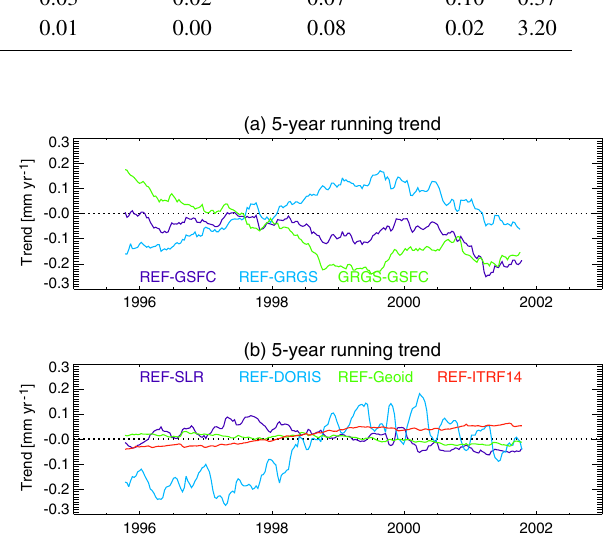
Figure 4. The 5-year running trends for the global mean radial orbit differences over the oceans for REF minus GSFC (dark blue), REF minus GRGS (light blue), and GRGS minus GSFC (green, a ); REF minus SLR (dark blue), REF minus DORIS (light blue), REF minus Geoid (green), and REF minus ITRF14 (red, b ). Trend values are given for the central time of the corresponding running